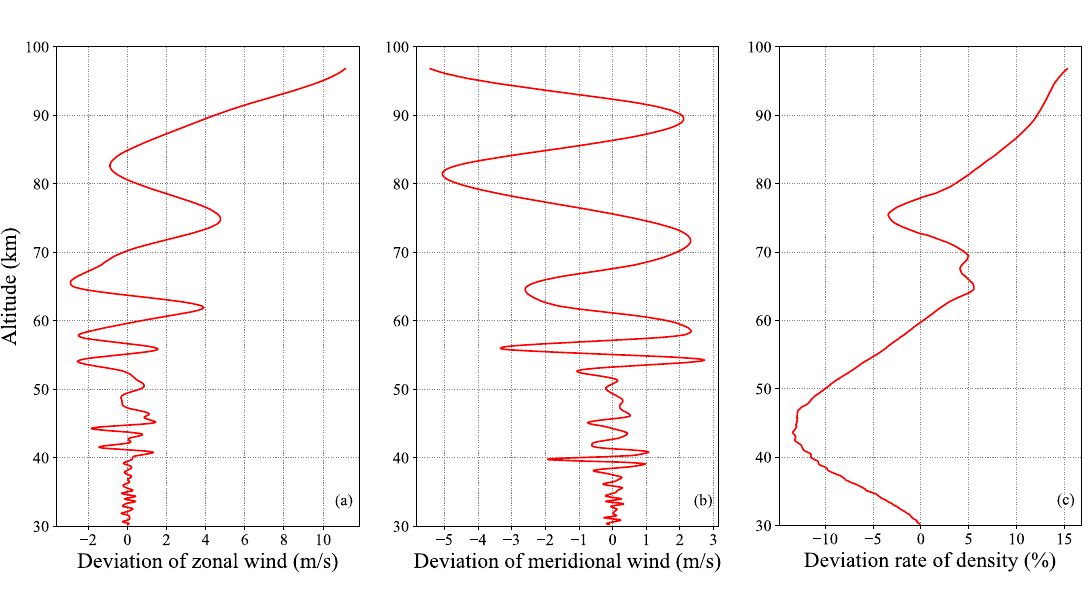
Figure 9. Inversion deviation of the single-falling-sphere method. ( a ) Deviation of the zonal wind; ( b ) deviation of the meridional wind; ( c ) deviation rate of the density.